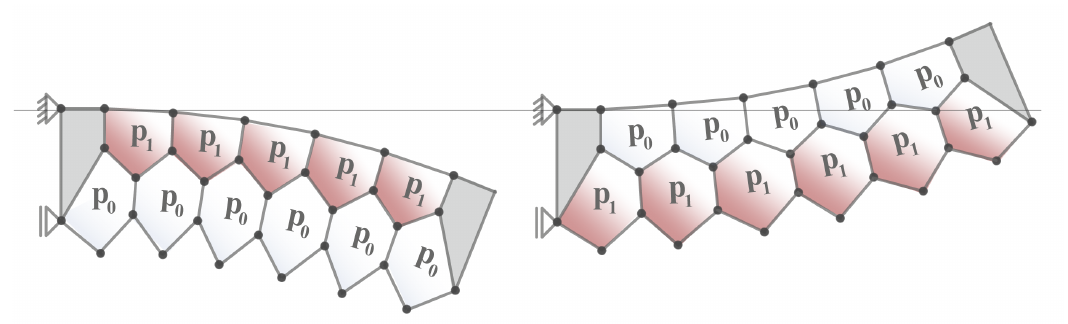
Figure 4. Two independent target shapes of a double-row cantilever. Reprinted/adapted by permission from Springer Nature